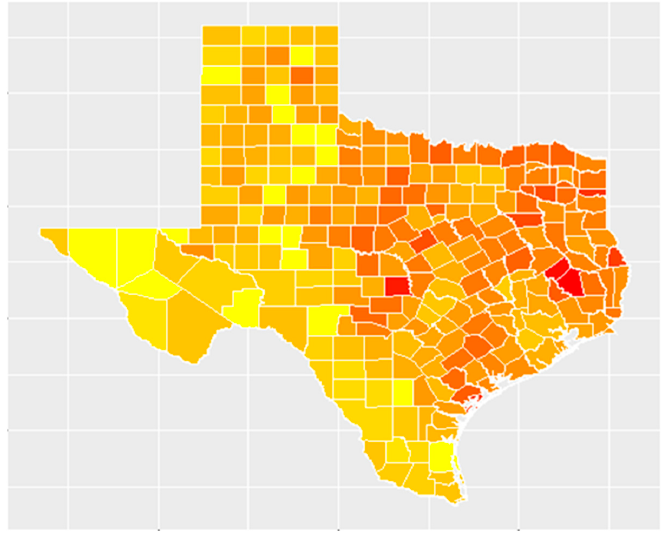
Figure 1. Incidence rates of benzene-associated cancers, 2004-2013.